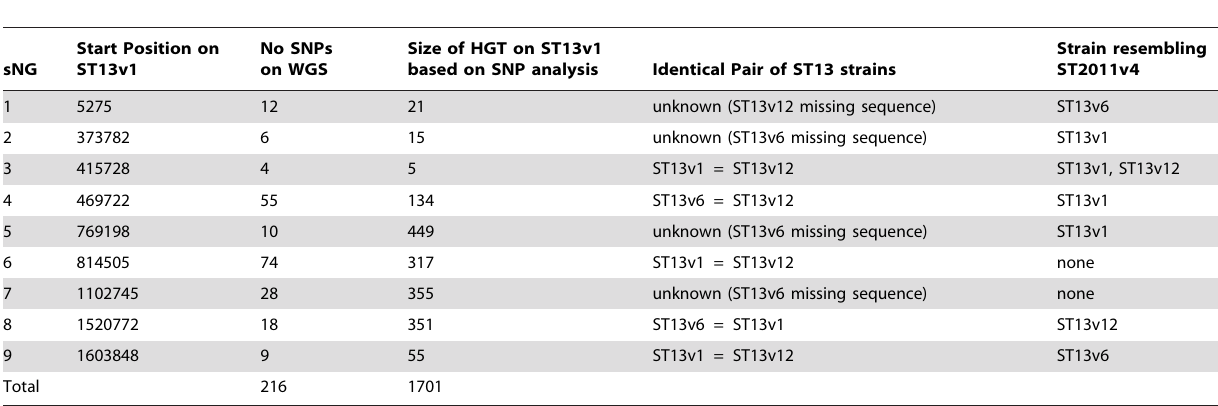
Table 5. Genic and allelic differences identified within small ( , 500 bp) regions of horizontal gene transfer among S. pneumoniae isolates from a single